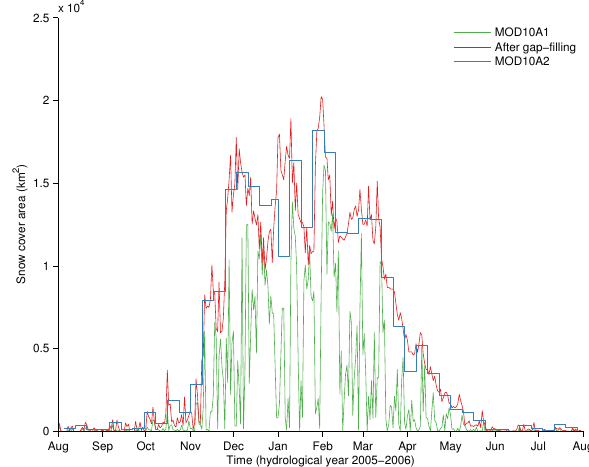
Figure 8. Snow cover area evolution in the Pyrenees over the hy- drological year 2005–2006 for three products: MOD10A1, the gap- filled product from MOD10A1 and MYD10A1 (this study) and MOD10A2 (8-day maximum snow